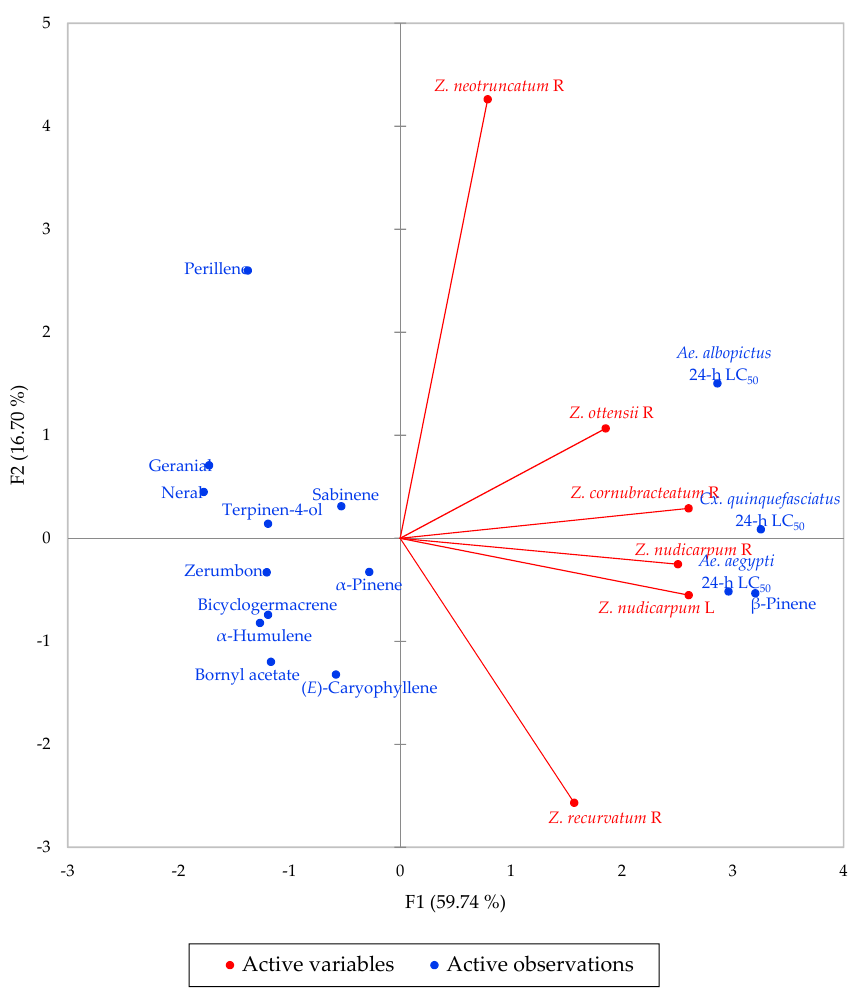
Figure 4. Principal component biplot of PC1 and PC2 scores and loadings indicating the correlations between Zingiber essential oil major components and larvicidal activities.